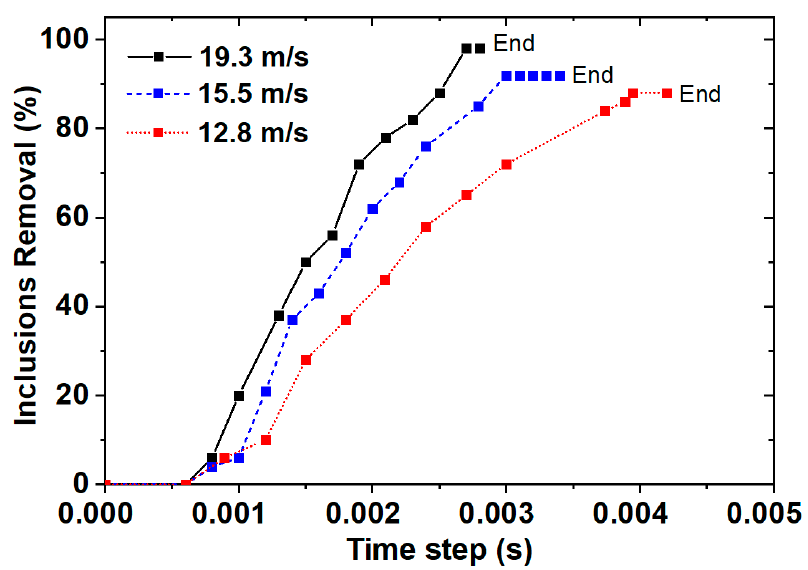
Figure 5. Predicted velocities of inclusion particles during upsetting operation.